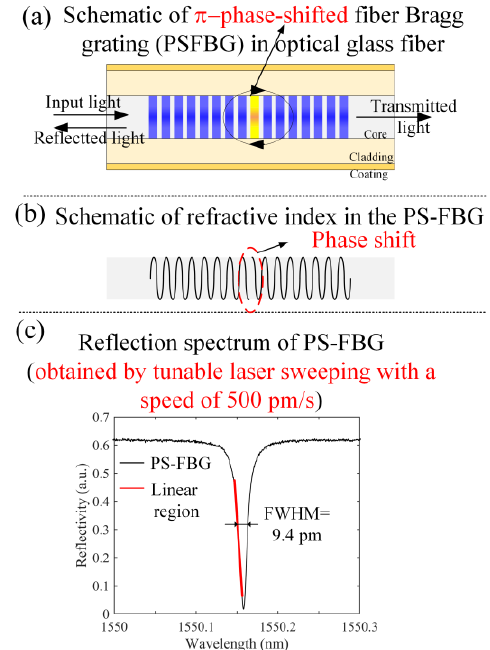
Figure 1. The introduction about PS-FBG.